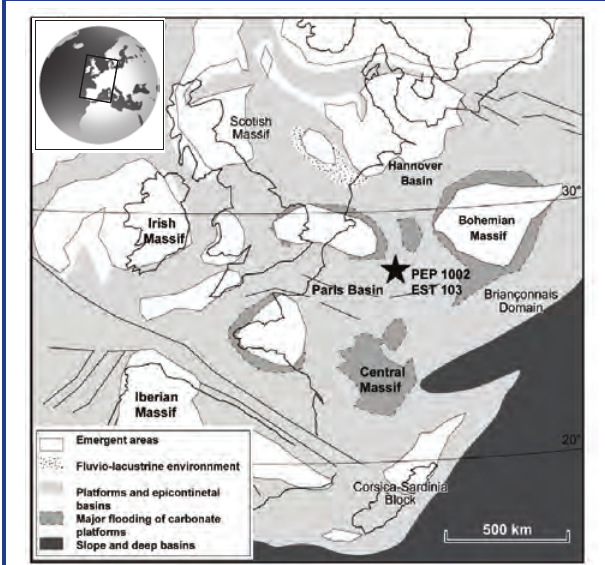
Figure 1. Paleogeographic map of the Paris Basin (indicated by stars) and surroundings (modified after Pellenard, 2003 and Dercourt et al.,